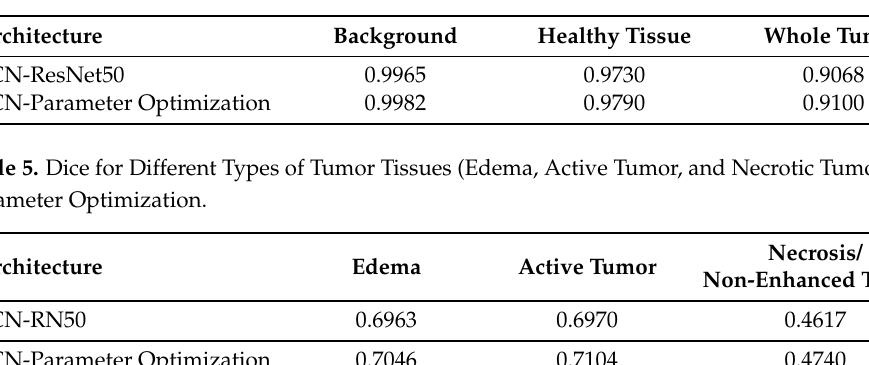
Table 4. Dice for Background, Healthy Tissue, and Whole Tumor with Parameter Optimization.